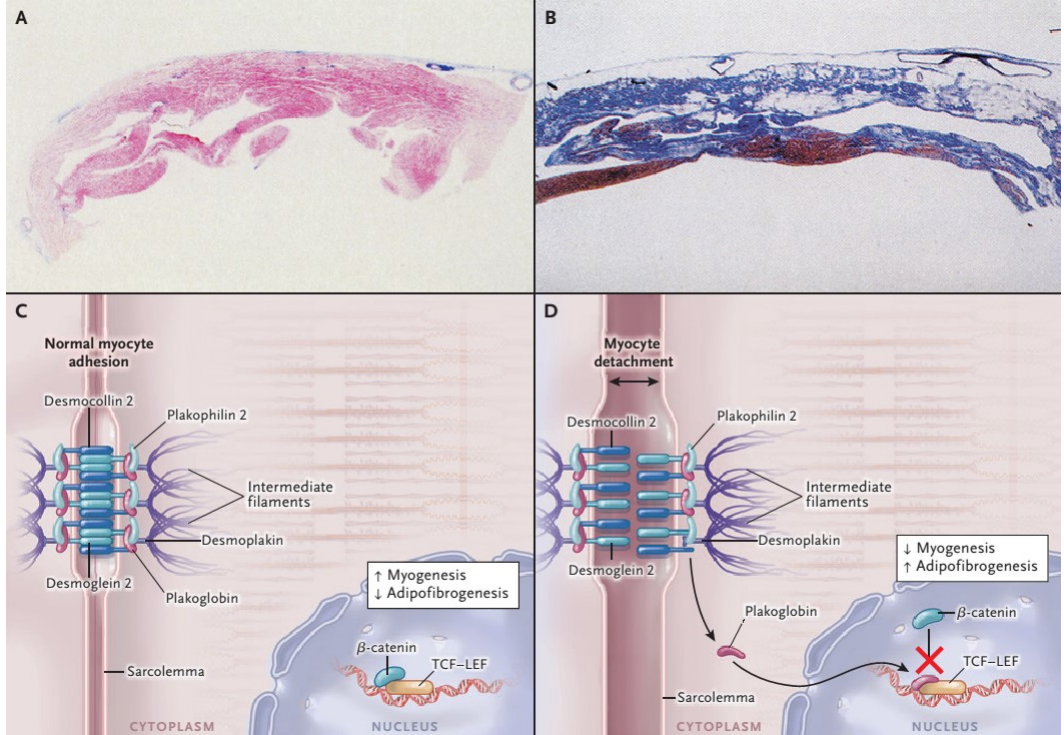
Figure 1. Histopathological Features and Pathogenesis of arrhythmogenic right ventricular cardiomyopathy (ARVC). With the azan trichrome stain, myocytes appear red, fibrous tissue appears blue, and fatty tissue appears white. Panel A shows a full-thickness histologic section (azan trichrome stain) of the anterior right ventricular wall in a normal heart; Panel B illustrates an analogous section from the heart of a patient with ARVC who died suddenly: Fibro-fatty tissue has replaced the muscular one. Desmosomes are not only structures supplying cell-cell adhesion, but they are also part of the Wnt– β -catenin signaling pathway, which suppresses the expression of adipogenic and fibrogenic genes (Panel C and D ). Therefore, on one hand the impairment of desmosomal lead to detachment of cardiomyocytes (double-headed arrow), on the other in a gene transcriptional switch from myogenesis to adipogenesis and fibrogenesis (Panel C and D ) [17]. Modified from Ref [4] with permission of the publisher.